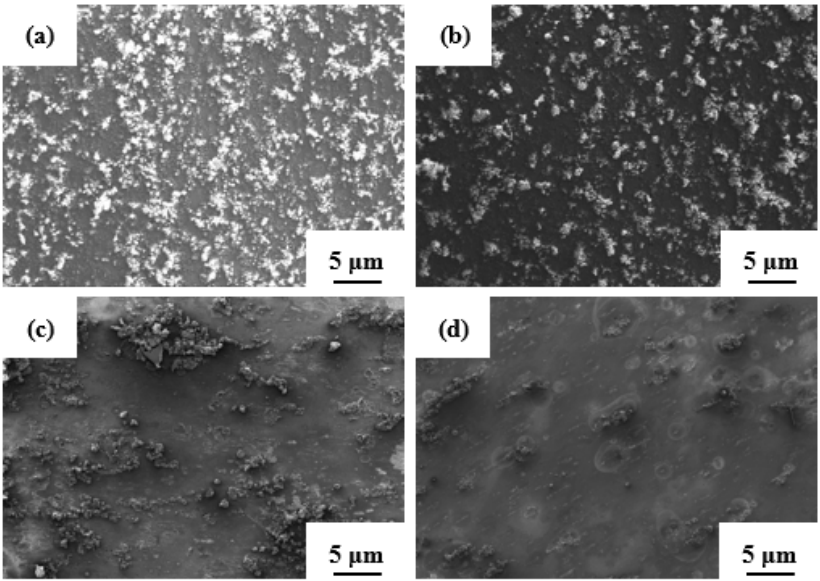
Figure 11. The scanning electron microscopy images of the ( a ) extruded Al-Zn-Mg-Cu samples annealed as a function of pressure and tested for corrosion in a 3.5 wt.% NaCl solution: ( b ) atmospheric pressure, ( c ) 2 GPa, and ( d ) 3 GPa, respectively.